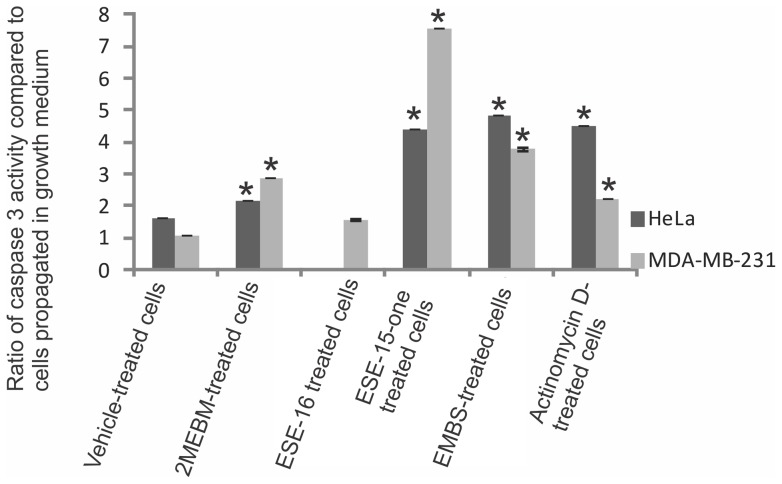
Caspase 3 activity in HeLa and MDA-MB-231 cells.Spectrophotometry results of caspase 3 activity indicated that after exposure to these sulphamoylated compounds caspase 3 activity increased significantly. An asterisk (*) indicates a statistically significant P-value <0.05 when compared to cells propagated in growth medium.